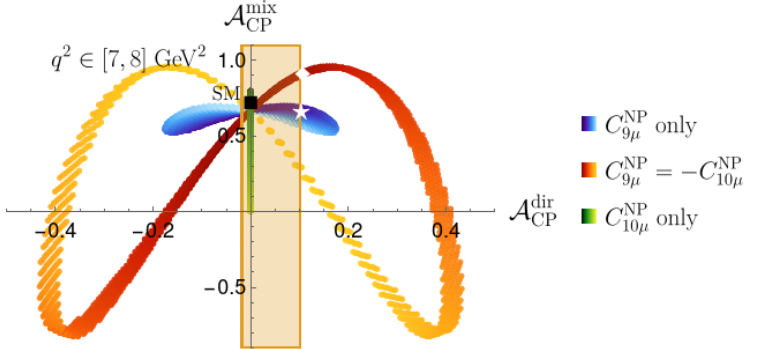
and A mix for the three NP scenarios CP CP